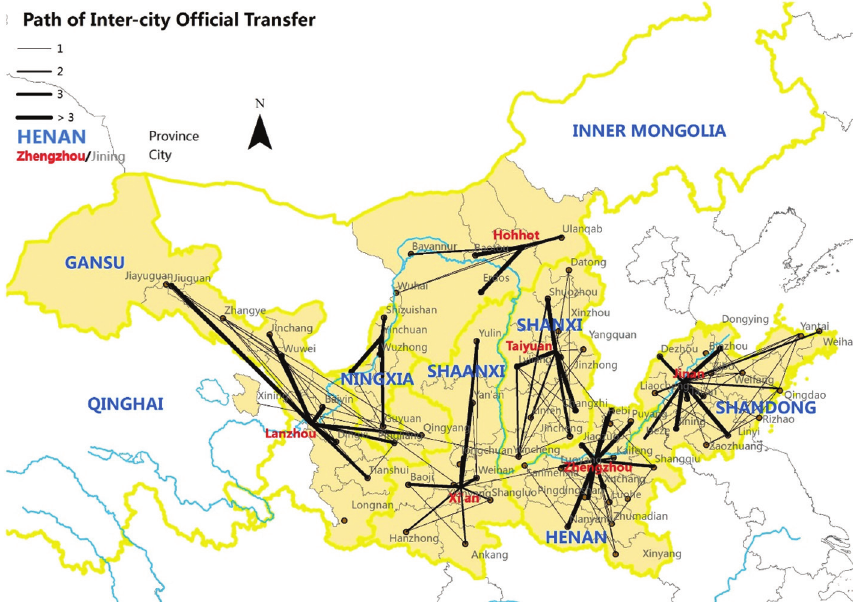
Figure 14: Path diagram of intercity official transfer in the Yellow River basin.